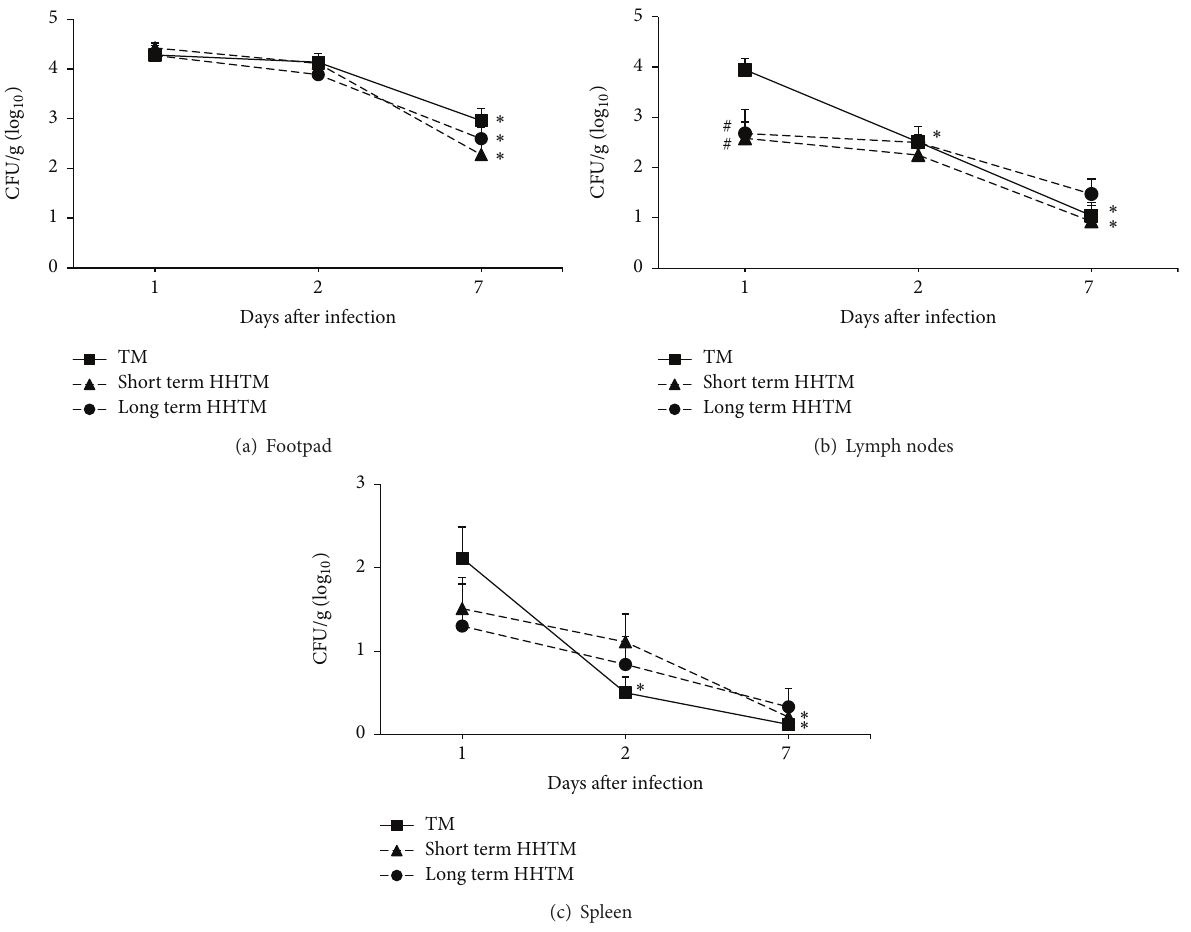
Figure 2: Microbiological evaluation. Swiss mice were infected with T. mentagrophytes and fungal load was evaluated 1, 2, and 7 days after infection in the footpads (a), popliteal lymph nodes (b), and spleen (c). The results are expressed as mean ± SD ( 𝑛 = 6 – 12 /group) of the CFU (log 10 ) per gram of tissue. Unpaired 𝑡 -test, 𝑝 < 0.05 . ∗ Statistical difference to day 1 and # statistical difference between TM and HHTM groups in the same time